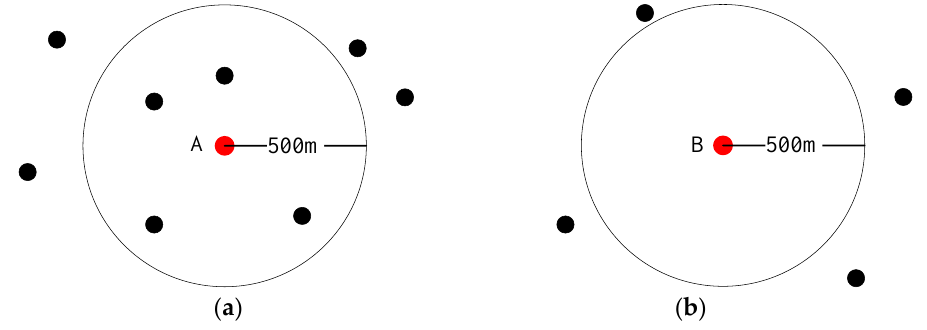
Figure 5. Examples of calculating 500 m-Stop Isolation. ( a ) Situation of stop A; ( b ) Situation of stop B.